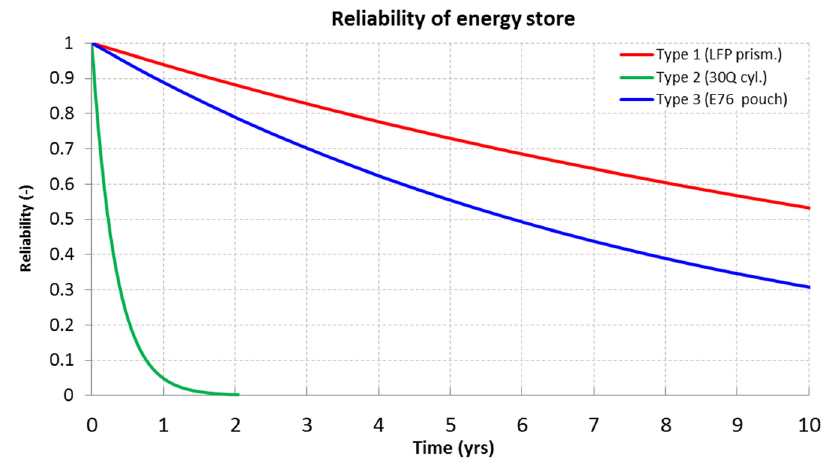
Figure 6. Reliability of different energy storage systems: Type 1: LFP—prismatic, Type 2: 30Q— cylindrical, Type 3: E76—pouch.